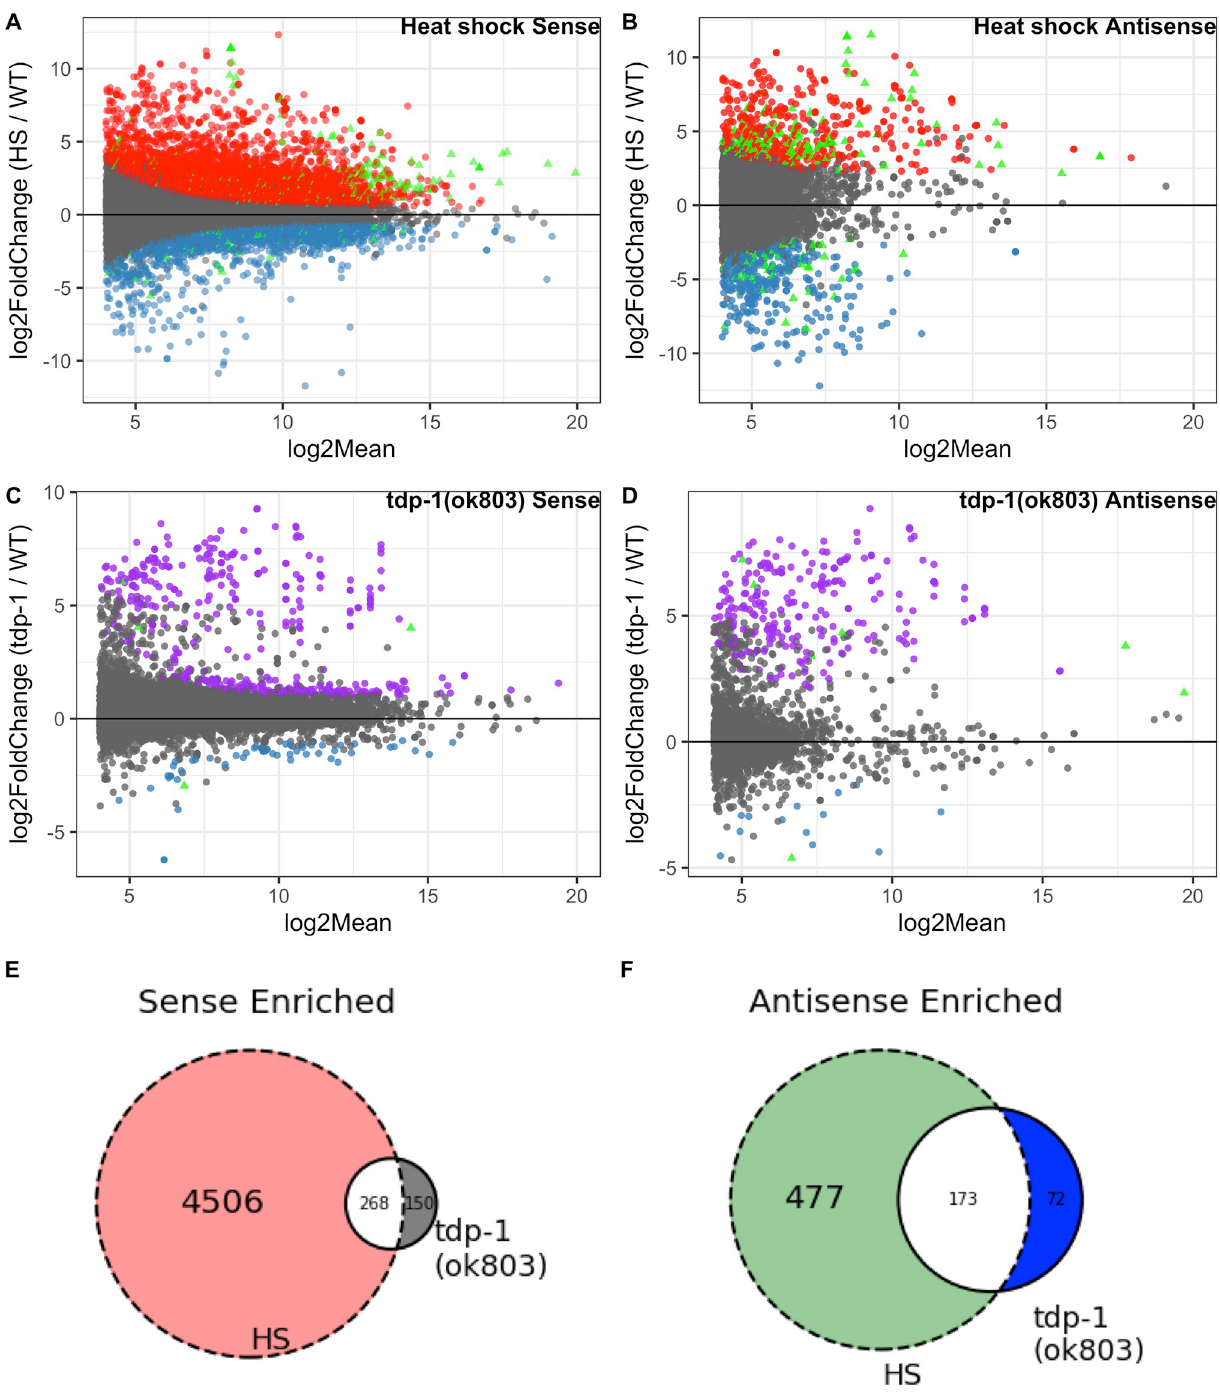
Fig 3. Comparison of J2 enriched sense and antisense transcripts in heat shock and tdp-1(ok803) worms. MA plots [“M” (log2FC) on y-axis and “A” (log2Mean) on x-axis] of significant (FDR < 0.05) dsRNA enrichment for sense and antisense transcripts (analyzed independently) along with Venn diagrams of enrichment for enriched sense and antisense [n = 2 for heat shock J2 samples, n = 3 for wild type, n = 3 for tdp-1(ok803) ]. (A) Heat shock over wild type J2 enriched sense transcripts with 4774 enriched (red) and 1669 depleted (blue). (B) Heat shock over wild type J2 enriched antisense transcripts with 650 enriched (red) and 477 depleted (blue). (A-B) enriched (180) and depleted (48) heat shock vs wild type transcripts found in both sense and antisense (green triangles). C: tdp-1(ok803) over wild type significant J2 enriched sense transcripts with 418 enriched (purple) and 59 depleted (blue). (D) tdp-1(ok803) over wild type significant J2 enriched antisense transcripts with 245 enriched (purple) and 14 depleted (blue). (C-D) enriched (6) and depleted (1) tdp-1(ok803) vs wild type transcripts found in both sense and antisense (green triangles). (E) Overlap of genes with significantly J2 enriched